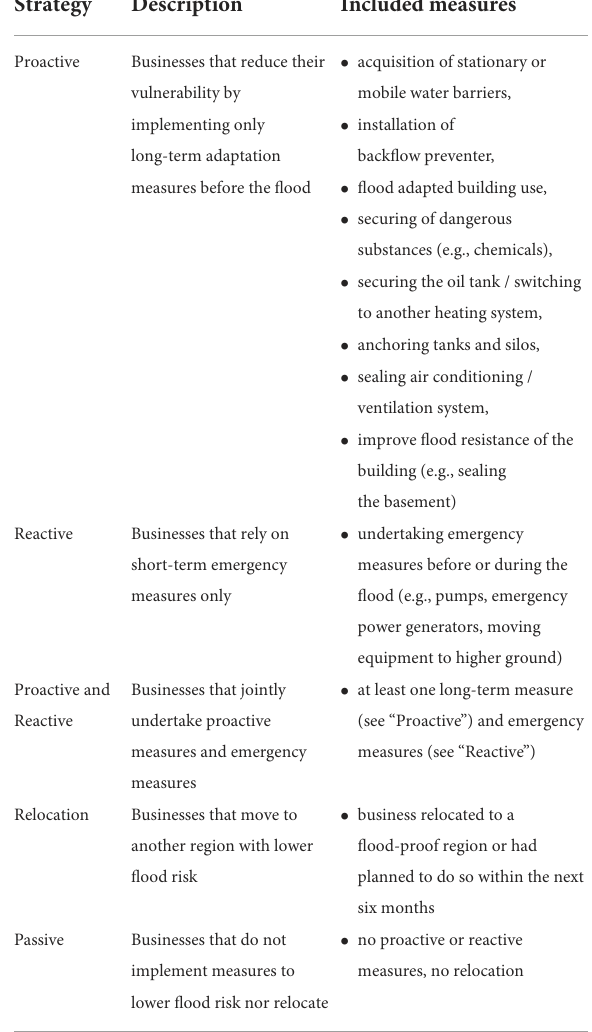
TABLE 2 Overview of the adaptation